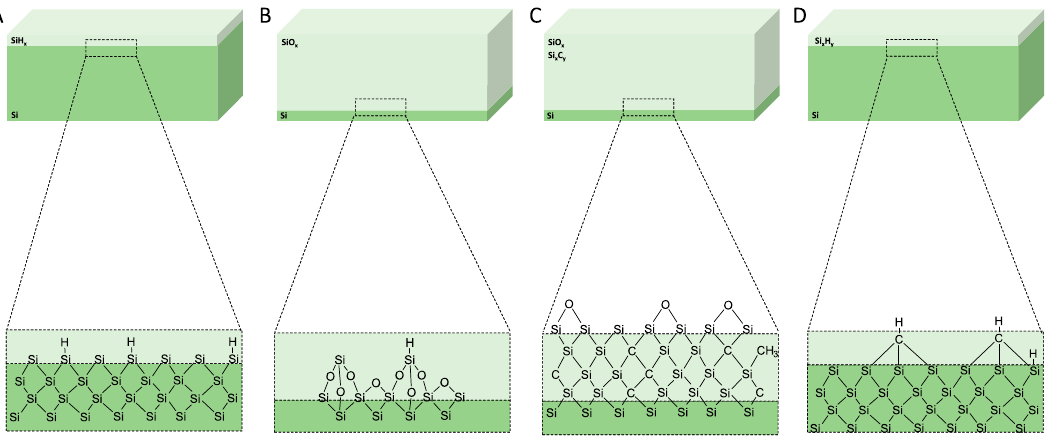
Figure 5. Schematics of the surface chemistry of the mesoporous materials after anodisation and after surface treatments. ( A ) As-anodised, ( B ) oxidised, ( C ) carbonised, and ( D ) hydrocarbonised. Reproduced with permission from [65].